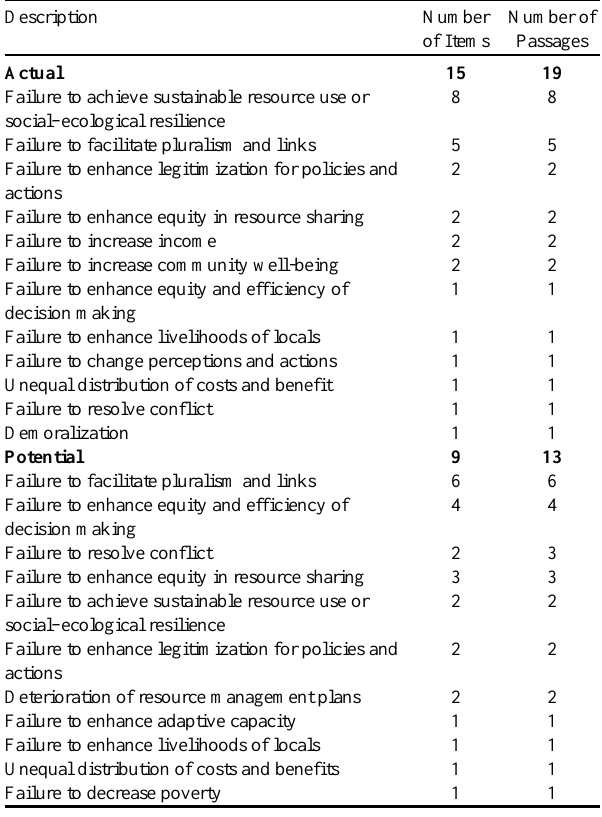
Table 6. Failures of adaptive